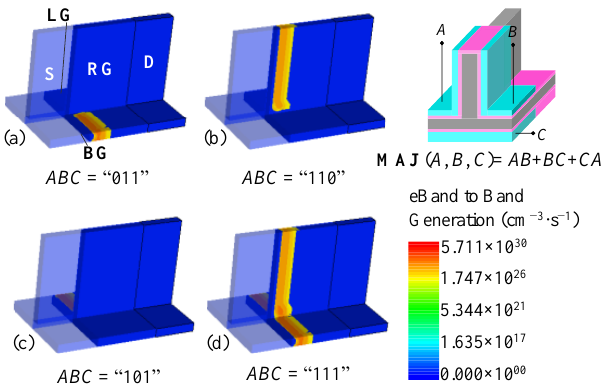
Figure 8. Schematic diagram of BTBT generation with different gate inputs in MAJ logic device. ( a ) ABC = “011”, ( b ) ABC = “110”, ( c ) ABC = “101”, and ( d ) ABC = “111”. To build a static complementary MAJ logic gate, a P-type TFET with MAJ behavior is also indispensable. The design of a P-type TFET is similar to an N-type TFET with reversed doping type. The doping concentrations of the N-doped source and P-doped drain are 1 × 10 20 cm − 3 and 4 × 10 18 cm − 3 . The I - V characteristics of the P-type device of φ = 4.22 eV are shown as dashed lines in Figure 7, which shows a good